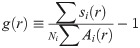
The correlation function.For each individual i, two quantities are measured: s
i(r), the number of conspecific trees in a ring of inner distance (from the focal tree) r and outer distance r + Δr, and A
i(r), the fraction of this ring area that is included in the 50-ha plot. The correlation function g(r)≡∑si(r)Ni∑Ai(r)−1 (the sum runs over all focal-specie's trees) measures the information about density fluctuations embodied in the observation of a tree at r = 0. g(r) = Ω(r) – 1, where Ω is the relative neighborhood density defined in [29], and is zero for a homogenous Poisson process. At long distances the decay of the correlations is described quite faithfully by a power law [33] (panel A, 15 most abundant species, panel C, all species). The short-distance correlation tends to be higher when a species is rare. This property is demonstrated in panel (E), where the height of the correlation function at r = 10m is plotted against the abundance, in parallel with Fig 2 of [29]. The rescaled plots (panels B and D) have the same slopes, since a power law is scale independent, but the crossover to the power law behavior is close to r/ℓ
0 = 1 for almost all species. Moreover, the association between abundance and correlation becomes non-significant in the rescaled plots, as seen in panel (F), showing the height of g(r / ℓ
0 = 0.5) vs. N
i. Pearson correlation coefficient in panel (E) is 0.46, with p-value less than 0.01, while for (F) the coefficient is 0.12 and the p-value is 0.1.